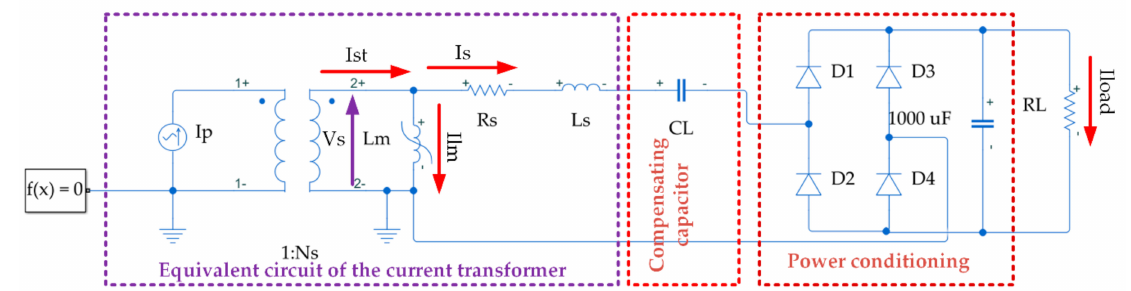
Figure 2. Equivalent electrical circuit of a CT-based electromagnetic energy